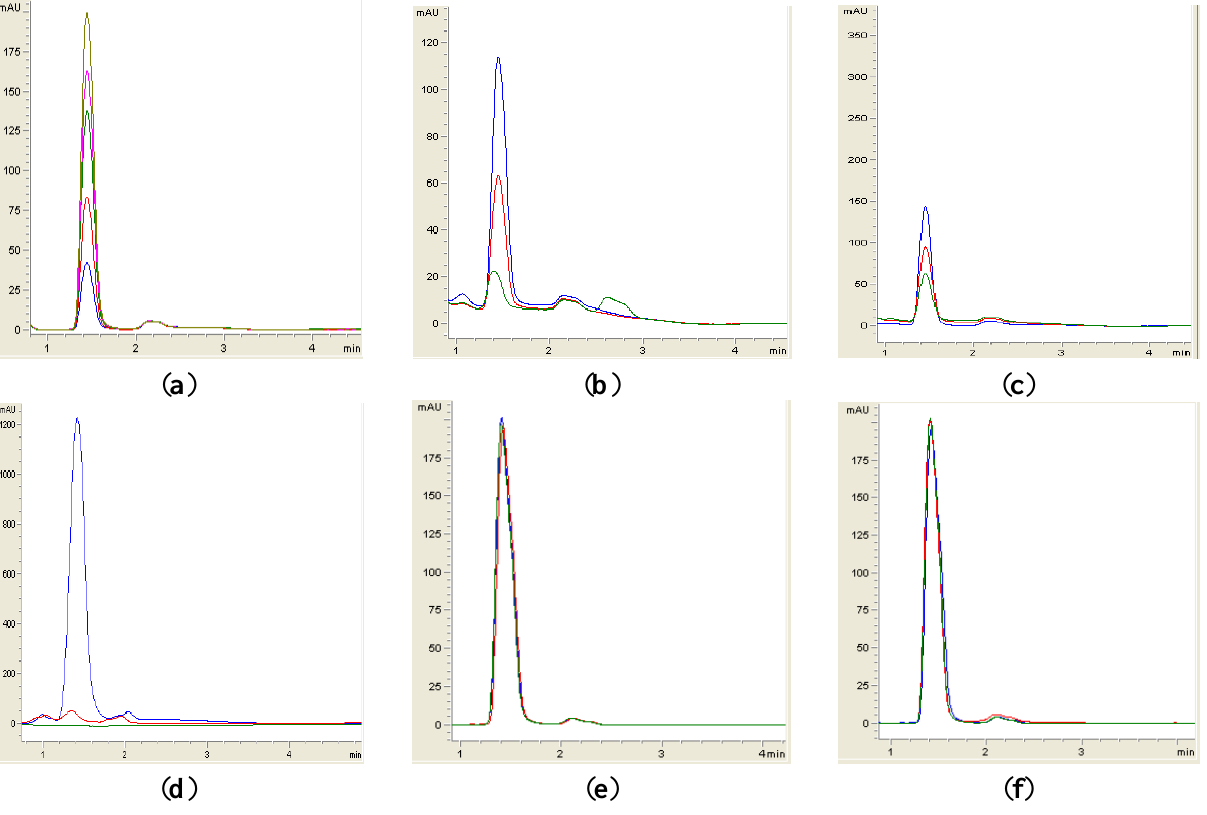
Figure 5. RRLC analysis of 3-hydroxy-C6-HSL degradation. Residual 3-hydroxy-C6-HSL (with elution time of 1.50 min ± 1.2 s), after degradation at 0 h (blue), 24 h (green) and relactonisation with HCl (red), was monitored at 210 nm. Degradation of 3-hydroxy-C6-HSL was depicted by the reduction of milli-absorbance units (mAU) in the